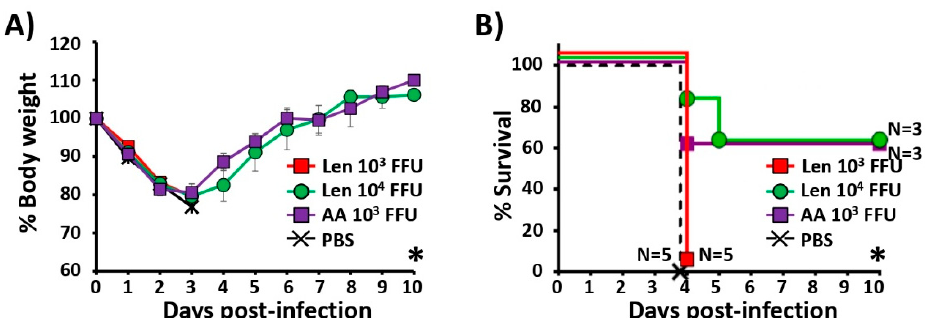
Figure 8. Protection efficacy induced by PR8/AA and PR8/Len against heterologous virus challenge. Six-to-eight-week-old female C57BL/6 mice ( n = 5) were infected i.n. with 10 3 and 10 4 FFU of PR8/Len or 10 3 FFU of PR8/AA viruses, or mock-infected (PBS). At 15 days p.i., mice were challenged i.n. with 50 MLD 50 of X-31 and then monitored daily over 10 days for body weight loss ( A ) and survival ( B ). Mice that lost 25% of their initial body weight were sacrificed. Data represent the means and SDs of the results determined for individual mice ( n = 5). Statistical analysis was performed using one-way ANOVA ( A ) and Dunnett’s ( B ) tests comparing the PBS group to the other groups (* P < 0.0001).